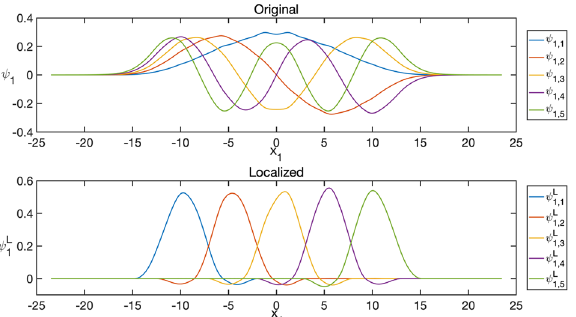
Fig. 2 1-D functions from separable Hamiltonian. 1-D functions in x 1 direction constructed from the additive separable approximation of the Kohn – Sham Hamiltonian for Al 147 nano-particle. Top: Lowest fi ve eigenfunctions of H 1 . Bottom: The corresponding L 1 localized 1-D functions.